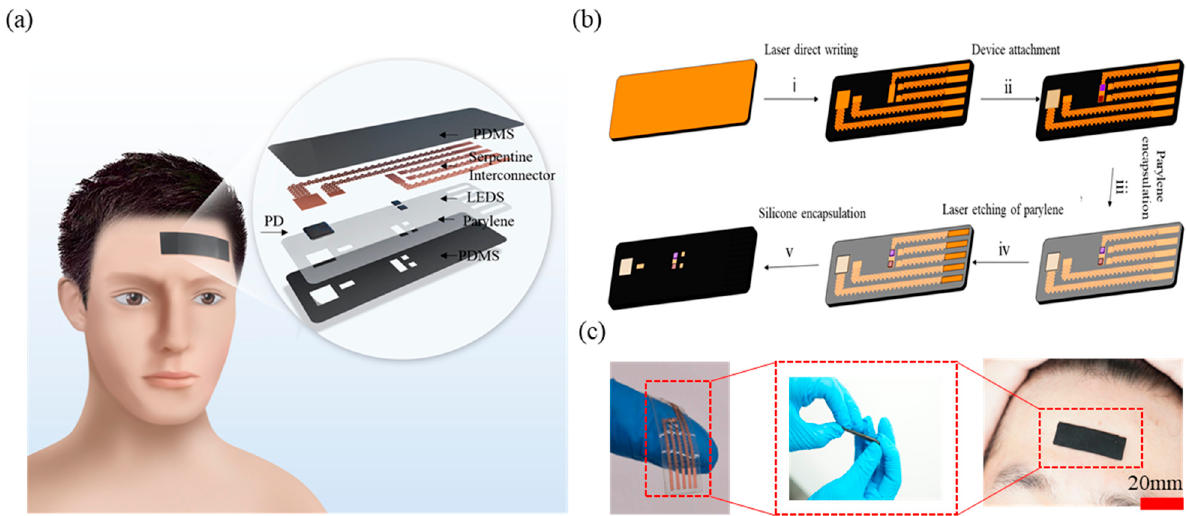
Figure 1. The flexible optoelectronic device. ( a ) Schematic diagram of the device for adult cerebral blood flow monitoring and the structure of fNIRS devices. ( b ) Device preparation process (patterning by laser direct writing, component bonding at low temperature, and in situ packaging). ( c ) Schematic diagram of the overall shape of the device and affixed to the forehead of a subject.